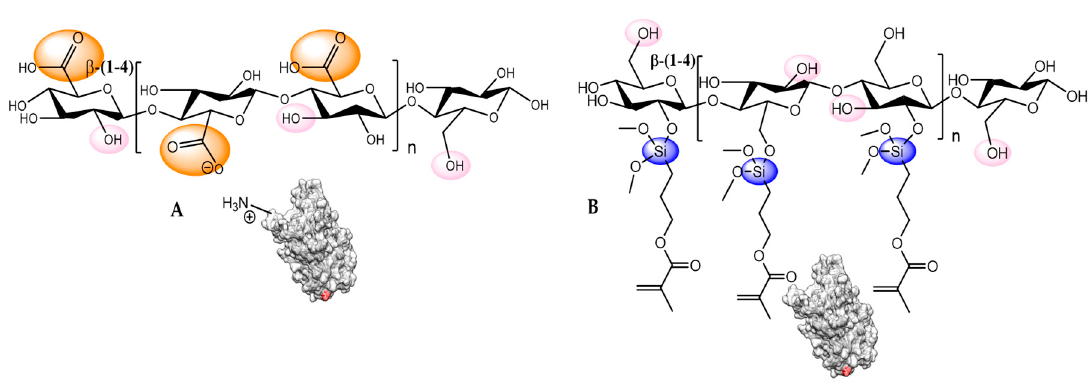
Figure 12. ( A ) Schematic representation of the structure of carboxyl-cellulose. ( B ) Schematic representation of the structure of cellulose modified with 3-(trimethoxysilyl)propyl methacrylate.